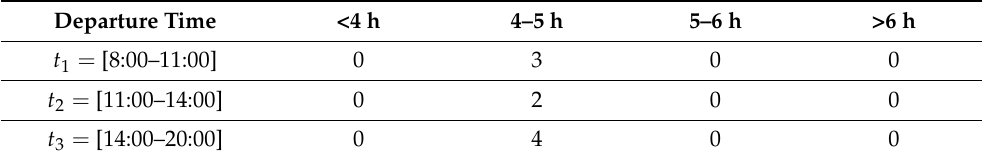
Table 8. Trains from Hangzhou to Changsha on 1 April 2022.